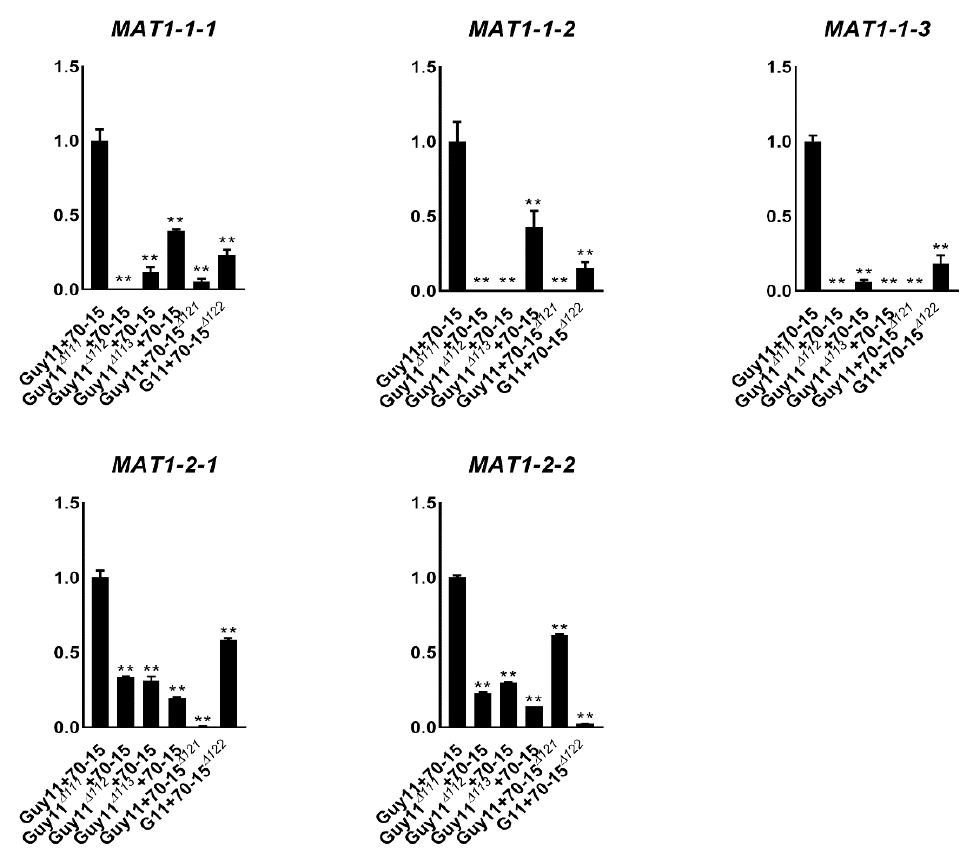
Figure 5. Transcription levels of the individual MAT genes in the MAT mutants. Relative transcription levels of the individual MAT genes in the crossing of Guy11 and 70-15, Guy11 ∆ 111 and 70-15, Guy11 ∆ 112 and 70-15, Guy11 ∆ 113 and 70-15, Guy11 and 70-15 ∆ 121 and Guy11 and 70-15 ∆ 122 . The transcription levels in the wild-type crossing (Guy11 + 70-15) were used as control for each MAT gene. Mean and standard error were calculated from three independent biological replicates. Single stars indicate significance at the 0.5 level and double stars indicate it at the 0.01 level.